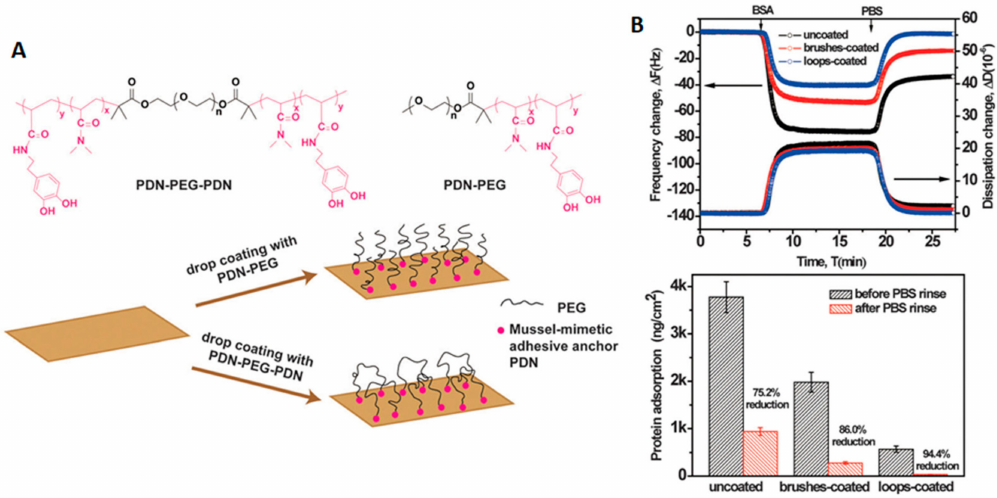
Figure 8. Antifouling loop-forming triblock copolymers. ( A ) structure of loop and linear polymers and representation of their use for coating a surface. ( B ) top: QCM-D traces showing changes in frequency and dissipation upon the absorption of BSA on surfaces uncoated or coated with loop or lineal PEG, and bottom: quantification of protein adsorption on the same surfaces (ng / cm). Reprinted (adapted) with permission from reference [51]. Copyright (2015) Royal Chemical